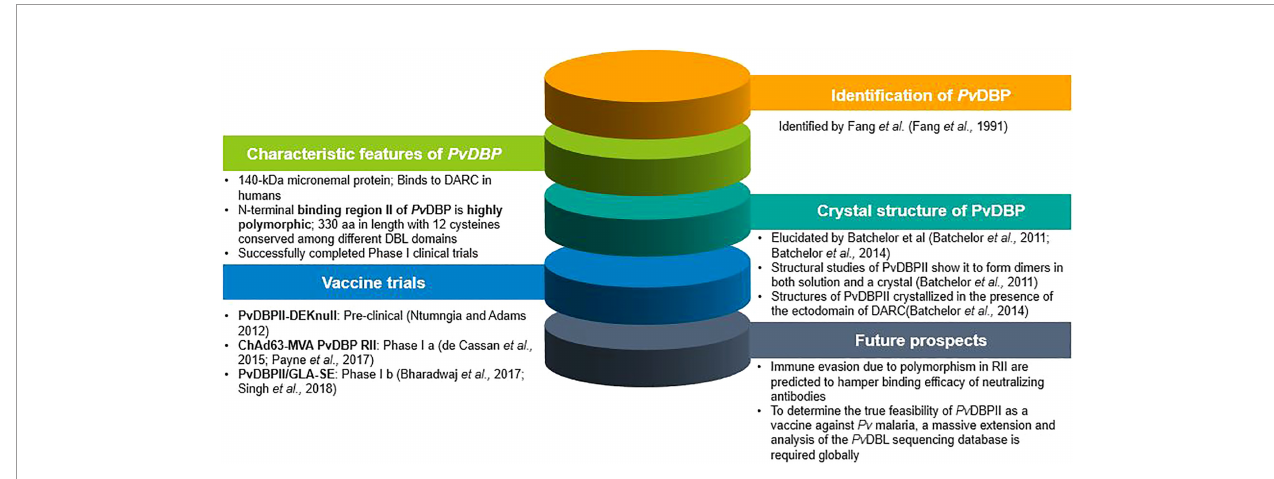
FIGURE 2 | Pictorial representation of landmarks in PvDBP